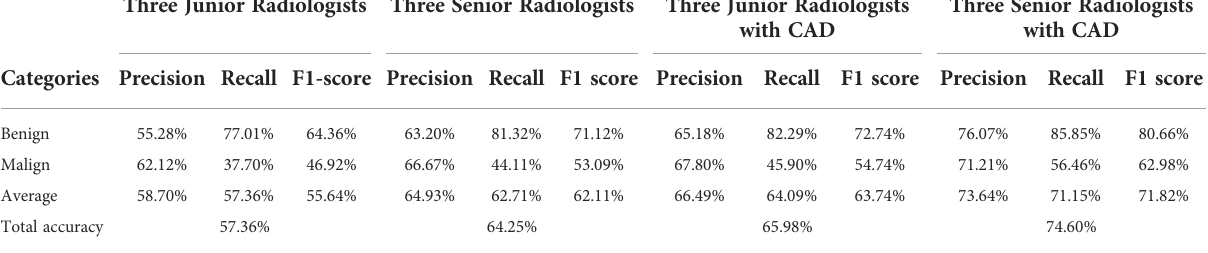
TABLE 9 Evaluation results on the unbalanced set. Three Junior Radiologists Three Senior